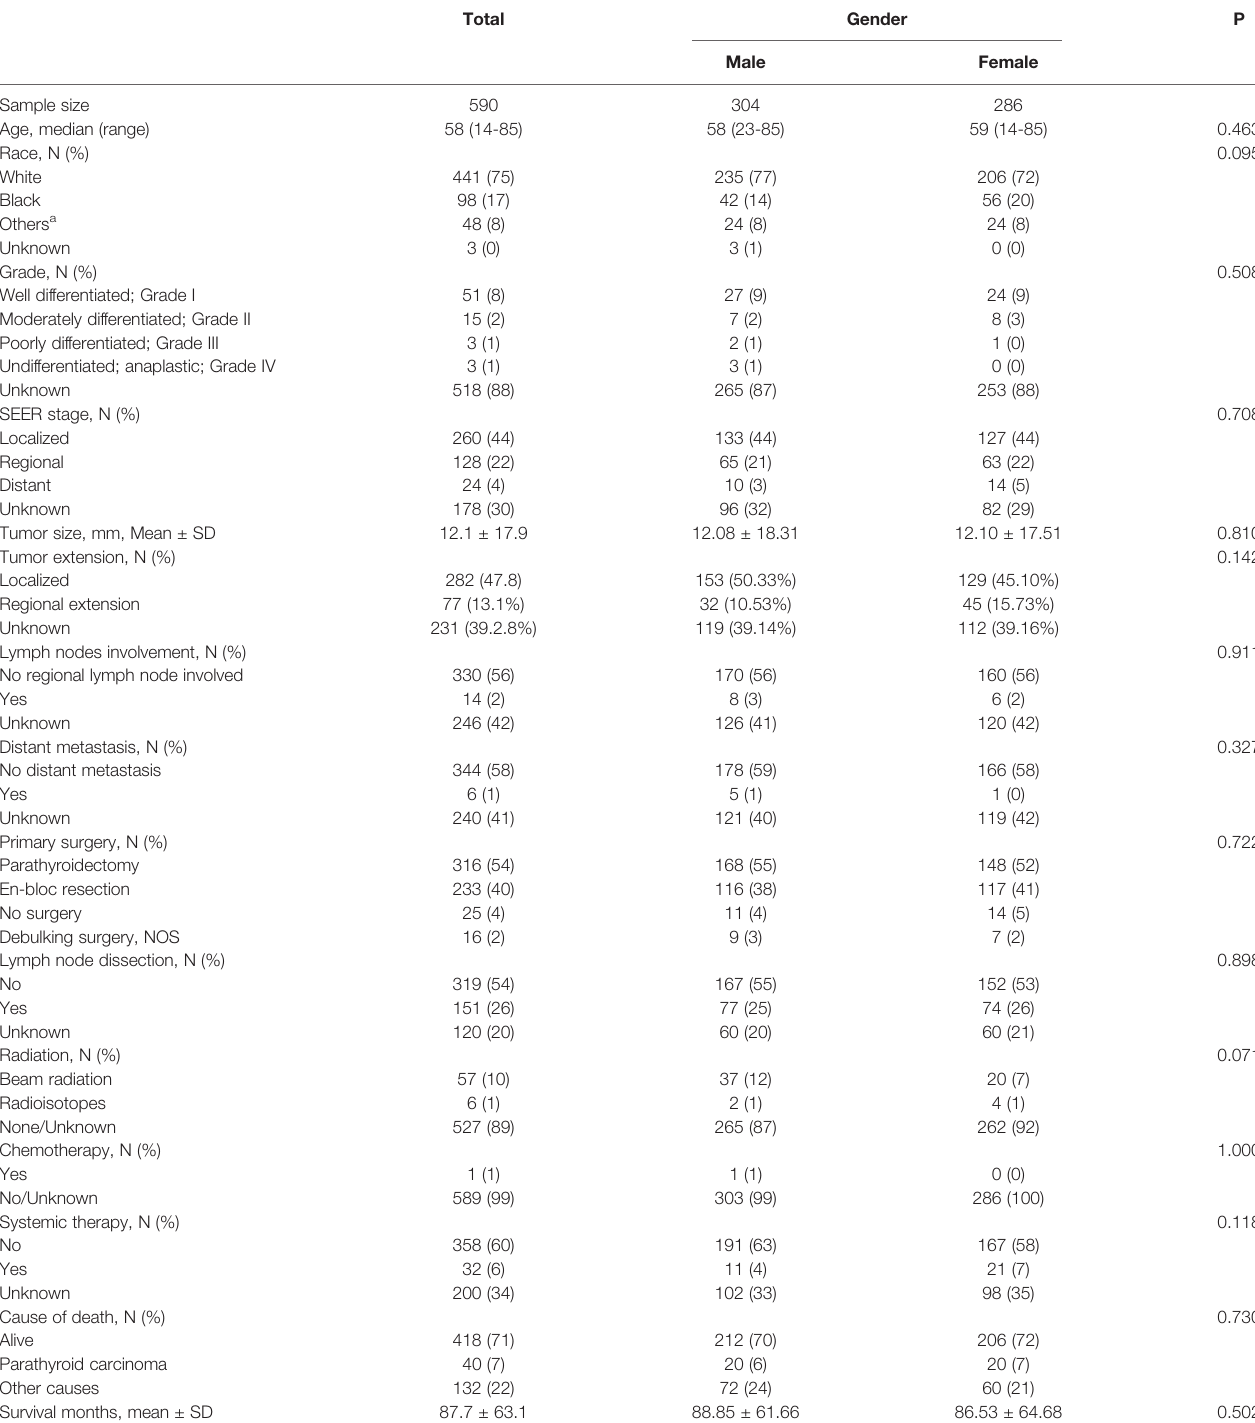
TABLE 1 | Demographic, clinical and treatment characteristics of PC patients between